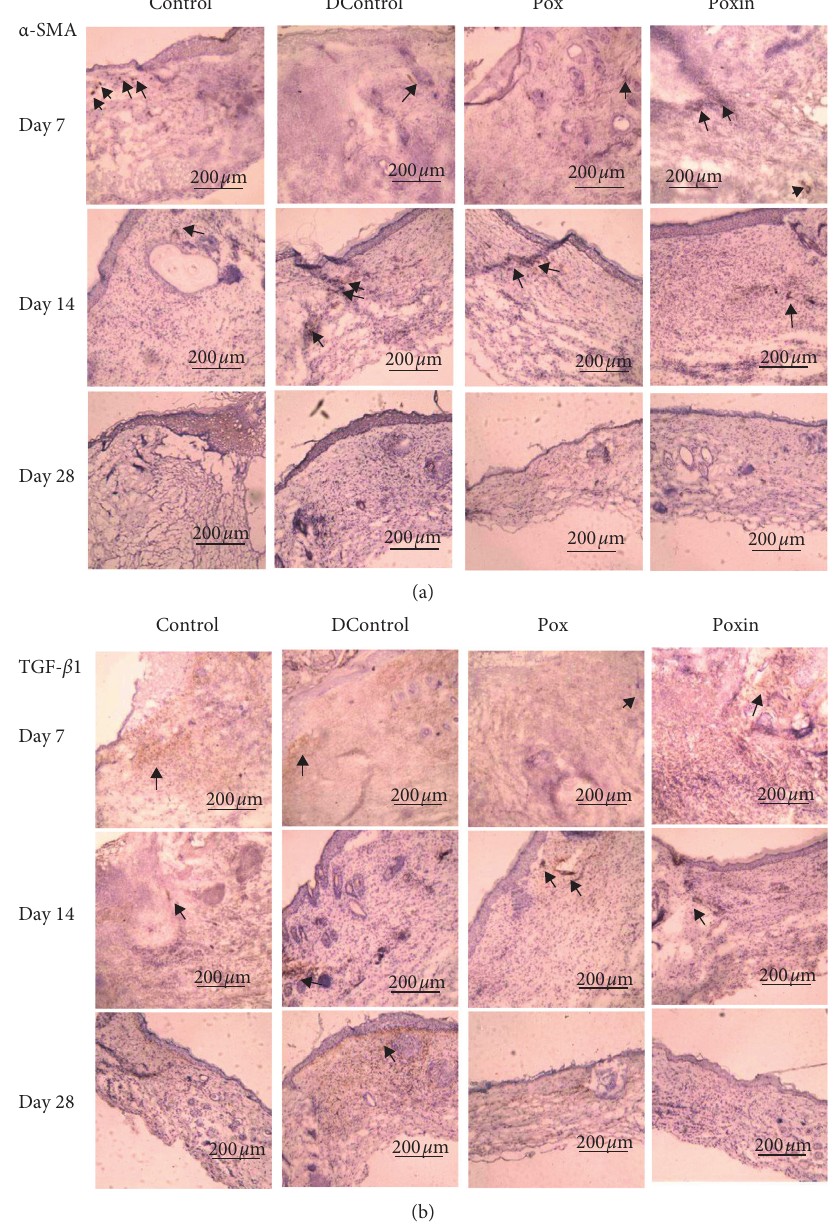
Figure 6: α -SMA and TGF- β 1 antigen expression in the wound bed on 7, 14, and 28 days after wounding: samples, DControl, Pox, and Poxin groups. Black arrows gave the examples about secretion sites of the